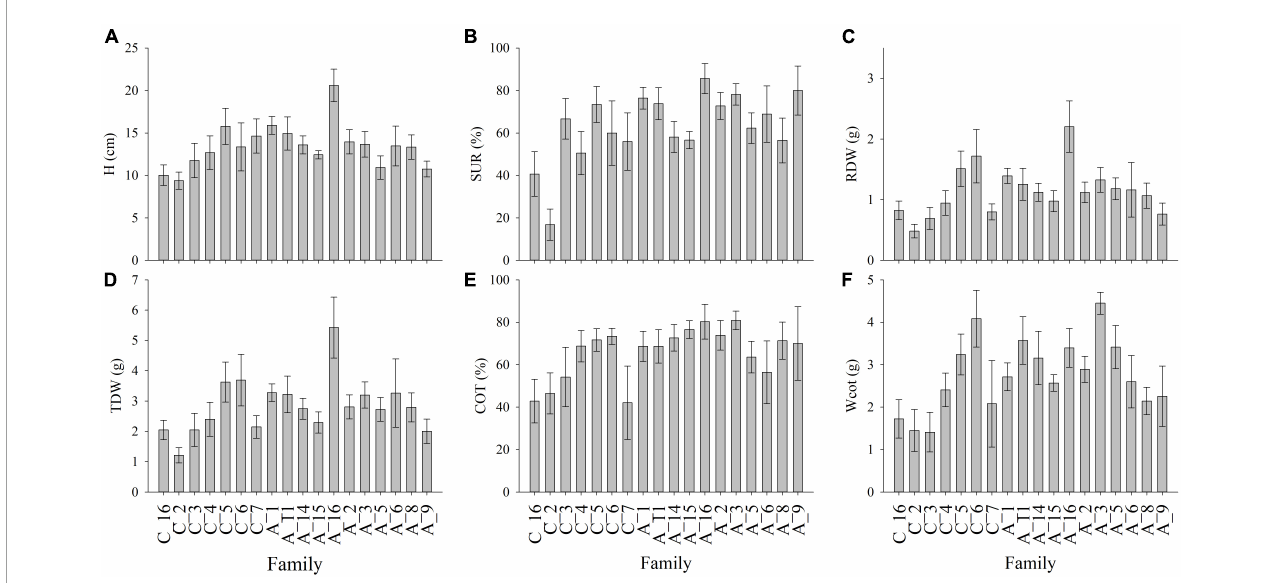
FIGURE2 Family variation for growth, survival, biomass allocation and weight of cotyledons in seedlings of Beilschmiedia miersii submitted to contrasting watering regimes. (A) H, height; (B) SUR, survival; (C) RDW, roots dry weight; (D) TDW, total dry weight; (E) COT, percentage of cotyledons; and (F) Wcot, weight of the cotyledon. C, families from provenance Cantillana; A, families from provenance El Arbol. Numbers after the dash corresponds to family